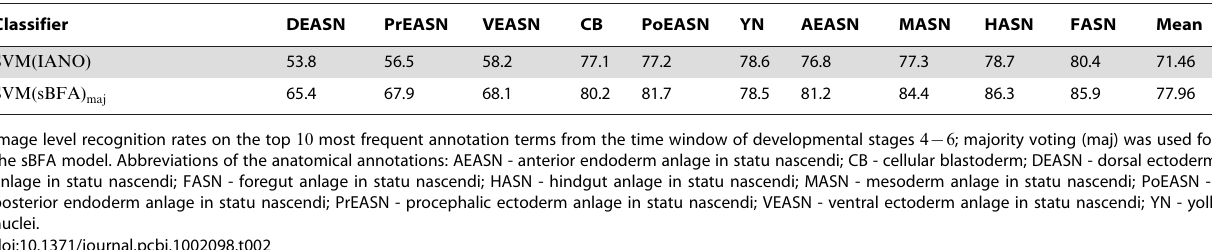
Table 2. Overall recognition rate ( % ) of the sBFA and IANO models, data set S l Classifier